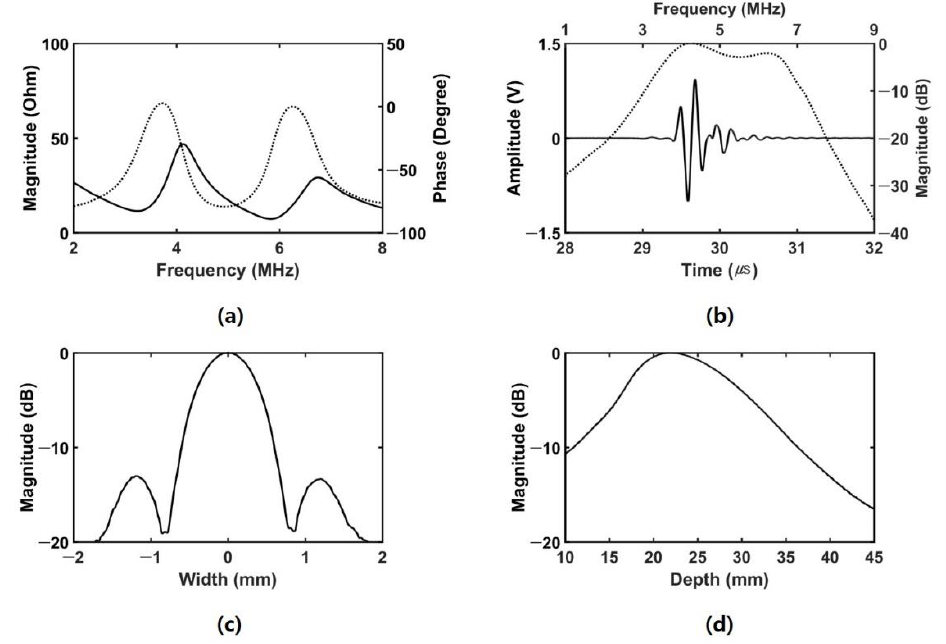
Figure 6. Measured properties of the transducer: ( a ) electrical impedance (solid line: magnitude, dashed line: phase), ( b ) pulse–echo response (solid line: time-domain waveform, dashed line: frequency-domain spectrum), ( c ) lateral beam profile, and ( d ) axial beam profile.